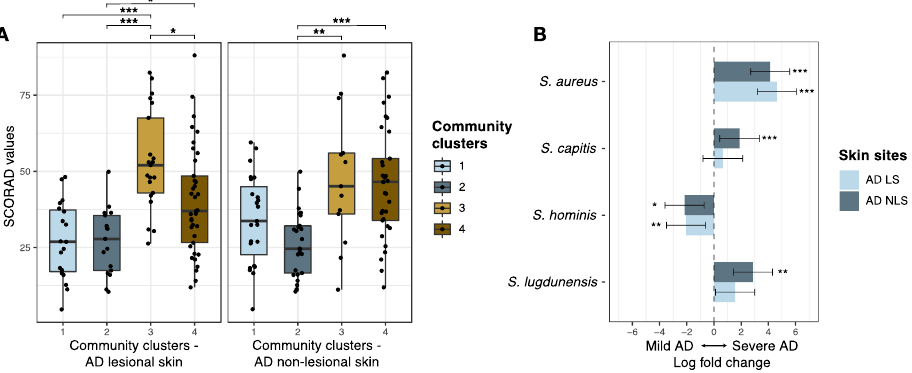
Figure 4. AD severity and cutaneous staphylococcal communities . ( A ) AD severity, assessed by SCORAD, and its association to staphylococcal community cluster assignments of lesional and non-lesional skin of AD patients ( n = 94). Boxplots represent the median and interquartile range (IQR) with whiskers extending to the minimum/maximum value, but no longer than 1.5xIQR. ( B ) Differential abundant staphylococcal species on lesional and non-lesional skin from patients with mild AD (SCORAD < 25, n = 25) as compared to patients with severe AD (SCORAD > 50, n = 21). Bars represent the ANCOM-BC estimated log fold change in species abundance between compared groups (effect size) and error bars, with the 95% confidence interval. Log fold change refers to the natural logarithm. Species with a fdr-adjusted p -value < 0.05 were considered significant and are shown in the plot. Asterisks indicate statistical significance: * adj. p < 0.05, ** adj. p < 0.01, *** adj. p < 0.001. Abbreviations: AD: atopic dermatitis; LS: lesional skin; NLS: non-lesional skin; SCORAD: Scoring Atopic Dermatitis.